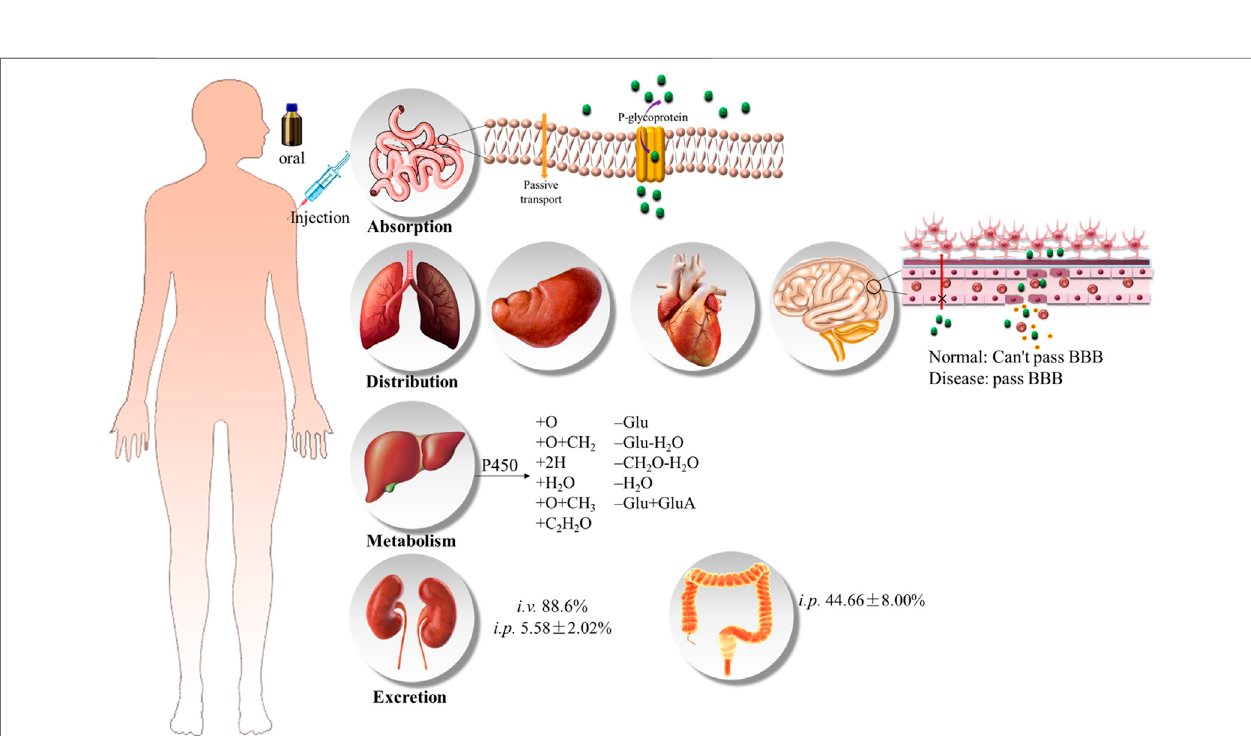
FIGURE 5 | Scheme of the pharmacokinetics of